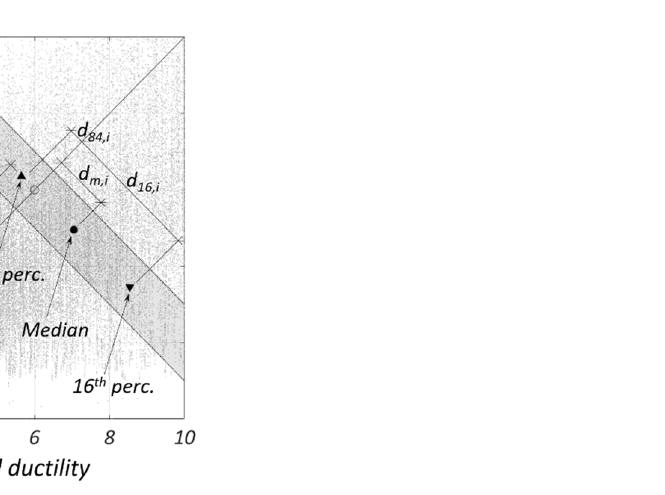
Figure 2. Comparison between predicted and NLTHA ductility demands: definition of diagonal bins and percentile distances from the bisector.